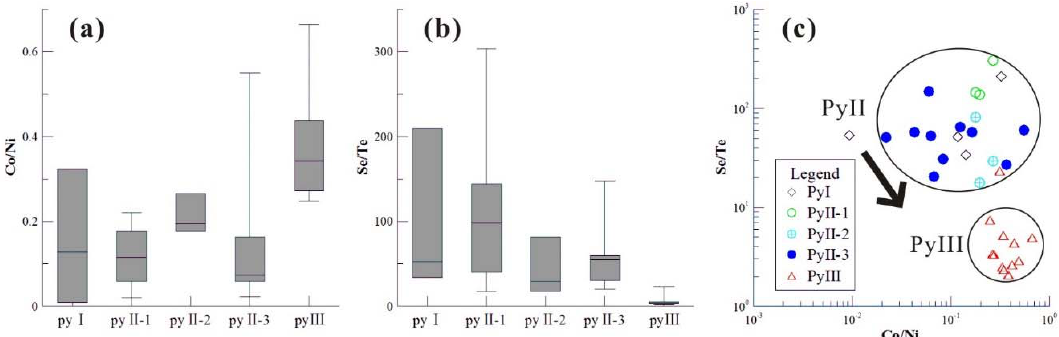
Figure 15. ( a , b ) Comparative box plot of the geochemistry of all generations of pyrite (LA-ICP-MS data), illustrating the range of ratios of Co–Ni and Se–Te. ( c ) Scatter plot of Se/Te and Co/Ni ratios, illustrating the distinct differences between PyII and PyIII (LA-ICP-MS data).